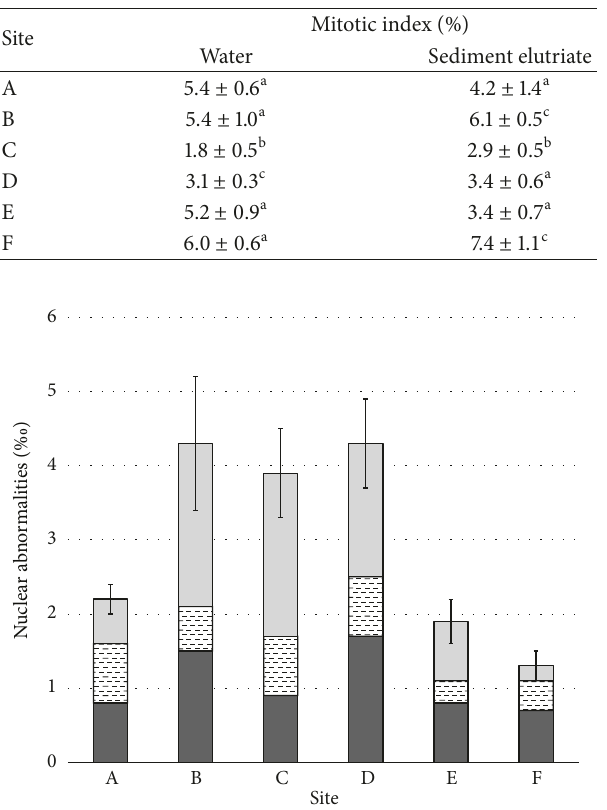
Table 5: Mean mitotic index of root tip cells of Allium cepa bulbs following exposure to water and sediment elutriates collected from study sites. Data are represented as mean ± SD. Results indicated by different superscript letters in each column are significantly different